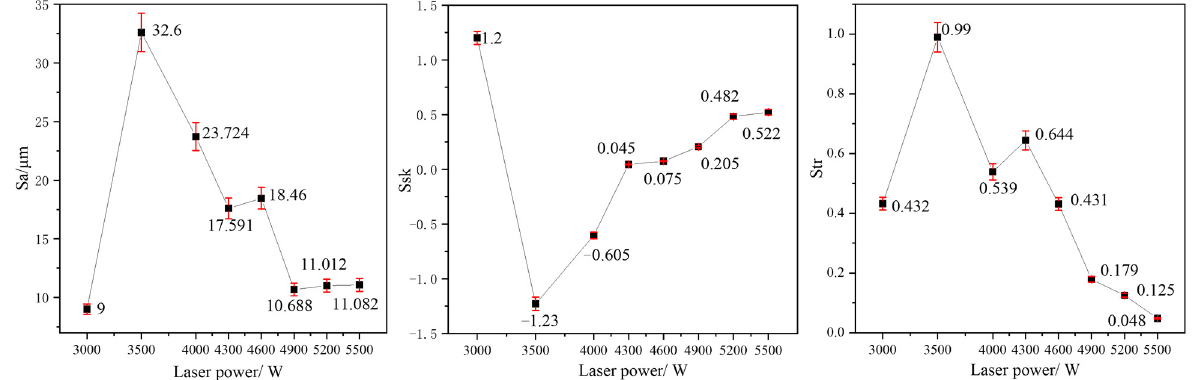
Figure 15. S a , S sk , and S tr as a function of laser power.